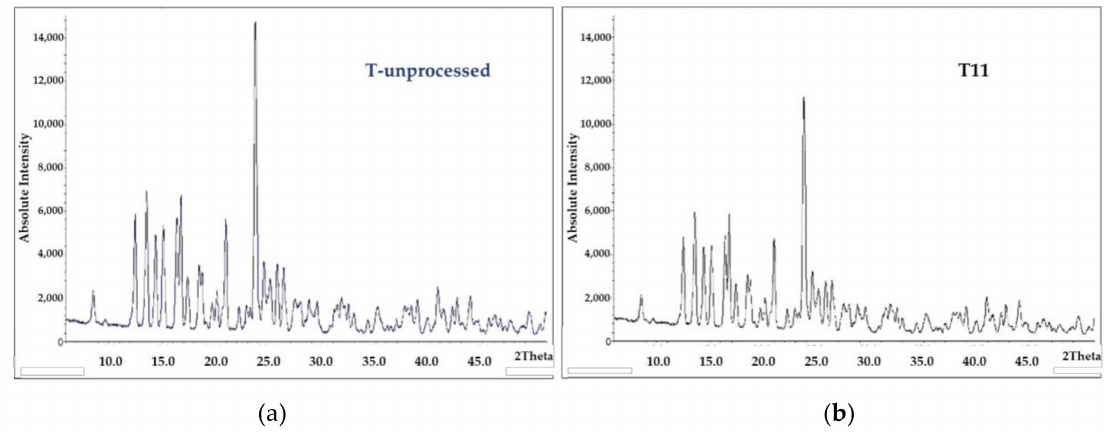
Figure 3. XRPD spectra of trehalose di-hydrate ( a ) before micronization (T-unprocessed) and ( b ) after the finest micronization